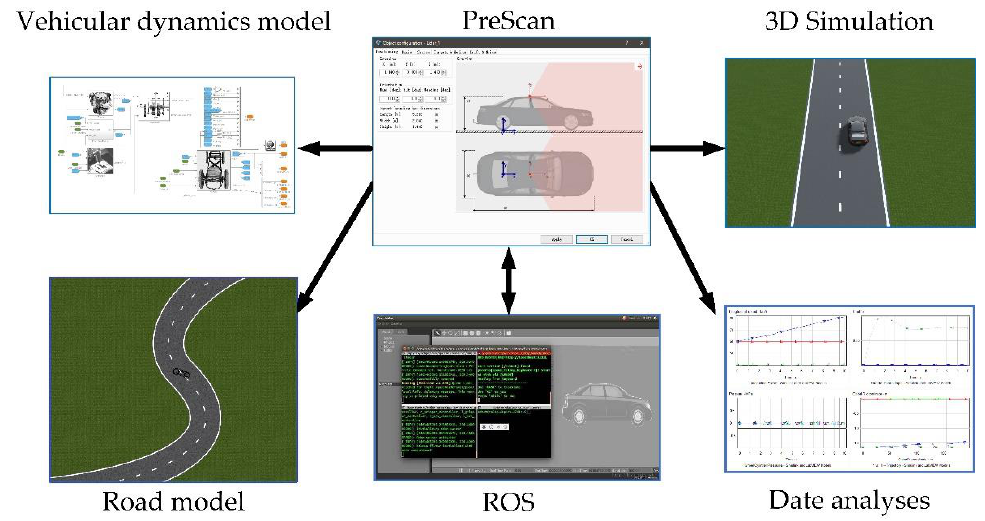
Figure 5. The construction of the co-simulation platform.